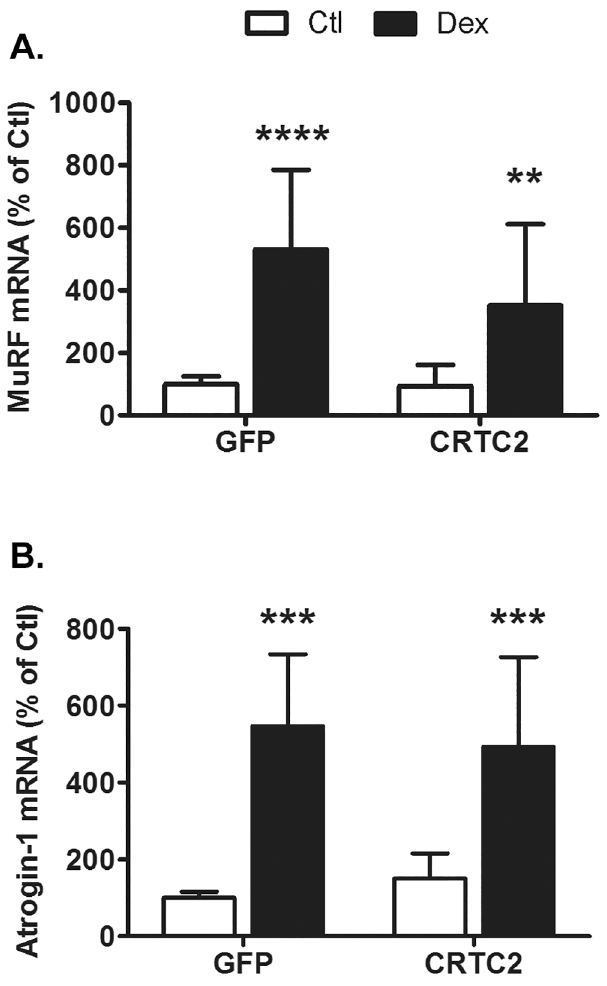
Fig 6. Dexamethasone, CRTC2, and atrogene expression. Two-way ANOVA was used to evaluate whether CRTC2 alters atrogene mRNA responses to Dex. Treatment with Dex increased (A) MuRF-1 mRNA (p < 0.0001) and (B) Atrogin-1/MAFbx mRNA (p < 0.0001). Overexpression of CRTC2 did not affect MuRF-1 or Atrogin/MAFbx mRNA expression (p (cid:1) 0.1) or effect the response to Dex treatment (p (cid:1) 0.1). n = 11-12/ treatment from 4 experiments. Data are expressed as mean percent of control ± s.d. Asterisks denote significant effects of Dex compared to respective controls as indicated by post hoc analysis: p < 0.01 = ** , p < 0.001 = *** and p < 0.0001 = ****